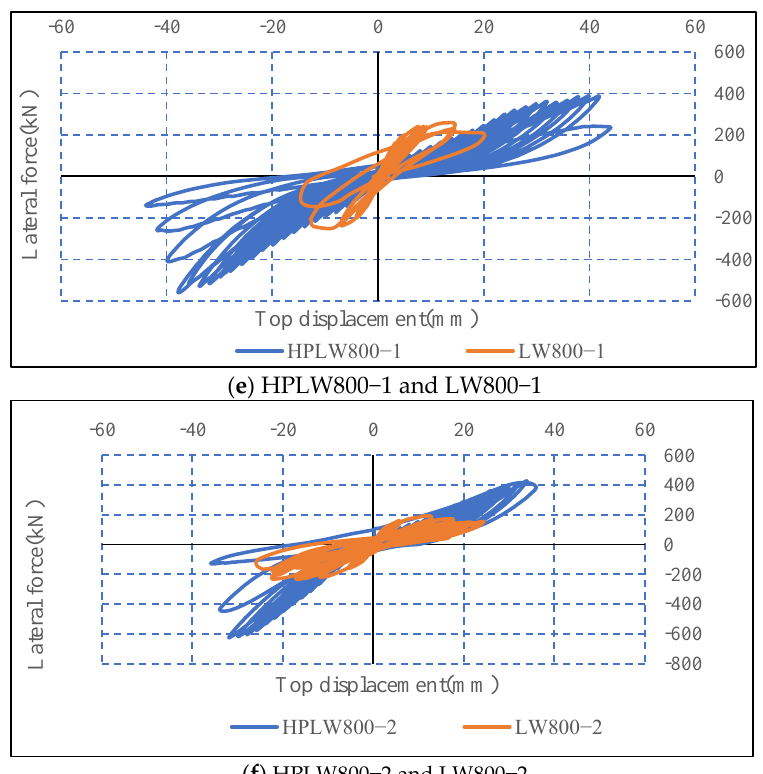
Figure 10. Lateral load – top displacement hysteresis curves of HPLW and LW wall.